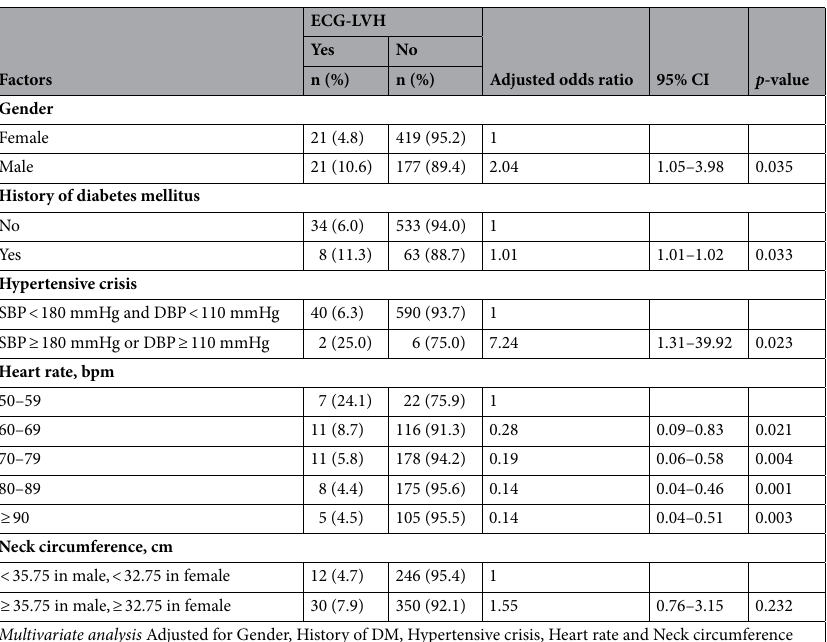
Table 3. Multivariate analysis factors associated with ECG-LVH among adults in a rural